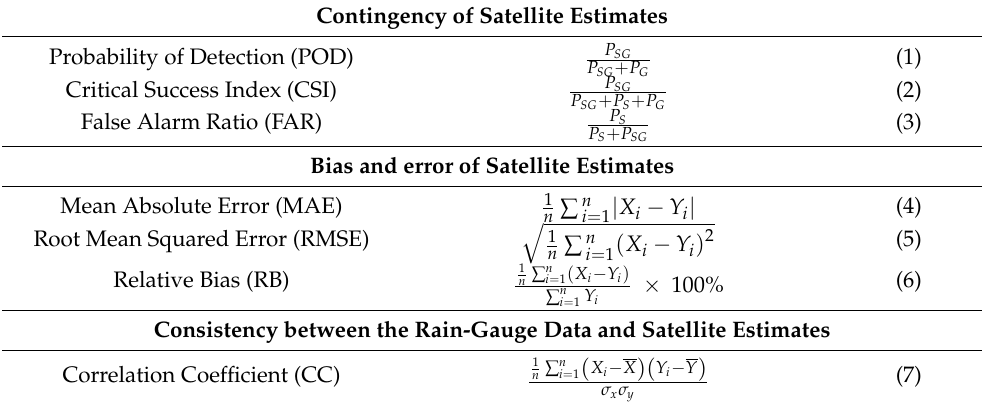
Table 1. Statistical measures used for evaluating IMERG SPPs.